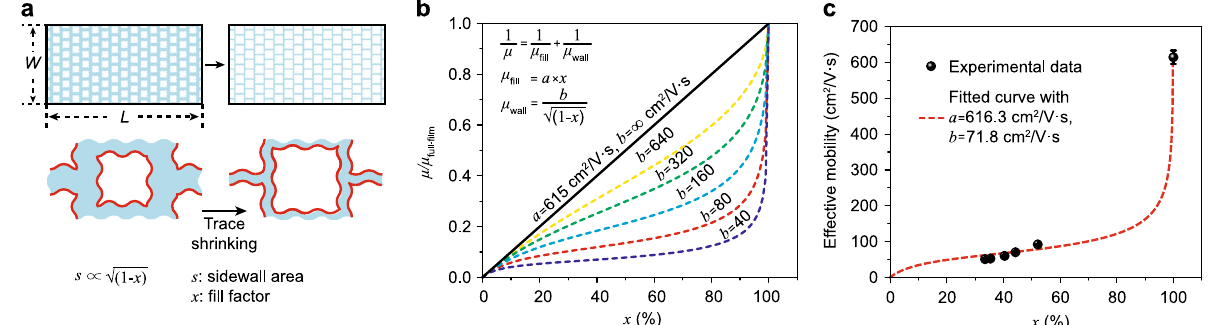
Fig. 3 Carrier transport modeling in Si nanomeshes. a Schematic concept of the analytical modeling which regards the nanomesh fi lm as a new material. Assuming the same nanomesh openings (indicated by the white areas among the light blue material parts) for the entire W × L area, the sidewall circumference (indicated by the red curves) will then always be proportional to the square root of the mesh-opening area, which is a natural consequence of the theorems about similar fi gures. The sidewall area ( s ), equal to the sidewall circumference times the fi lm thickness, will therefore also be proportional to the square root of (1 – x ). b Dependence of nanomesh mobility on fi ll factor which is affected by fractional material ( µ fi ll ) and scattering of trace sidewall ( µ wall ) using “ Matthiessen ’ s Rule ” . Here µ fi ll and µ wall are approximated as a × x and ffiffiffiffiffiffiffiffiffiffiffi p b = 1 (cid:1) x respectively, where a and b are materials and surface dependent prefactors. c Fitting of experimental effective mobility of semiconductor nanomeshes as a function of fi ll factor using the analytical model here. A fi tting curve with a = 616.3 cm 2 /V·s and b = 71.8 cm 2 / V·s matches closely with experimental data shrinking of the blue area in Fig. 3a. If we denote x as the fi ll factor dilution perspective, where a is a constant with a value equal to of Si in the W × L channel area, neglecting the scattering from the full fi lm mobility, µ full- fi lm . On the other hand, there are increasing sidewall areas if the trace sidewalls, the fractional-material induced mobility ( µ fi ll ) can nanomesh trace narrows. Assuming all nanomesh openings have be calculated as a × x to the fi rst order as we have discussed in the